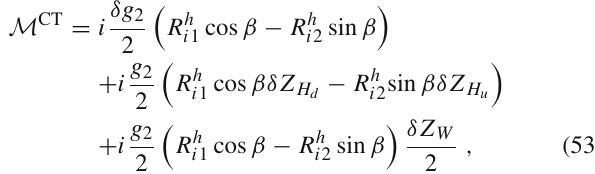
with scalars, fermions and gauge bosons in the loops, and the diagrams involving four-particle vertices. The countert- erm amplitude is given